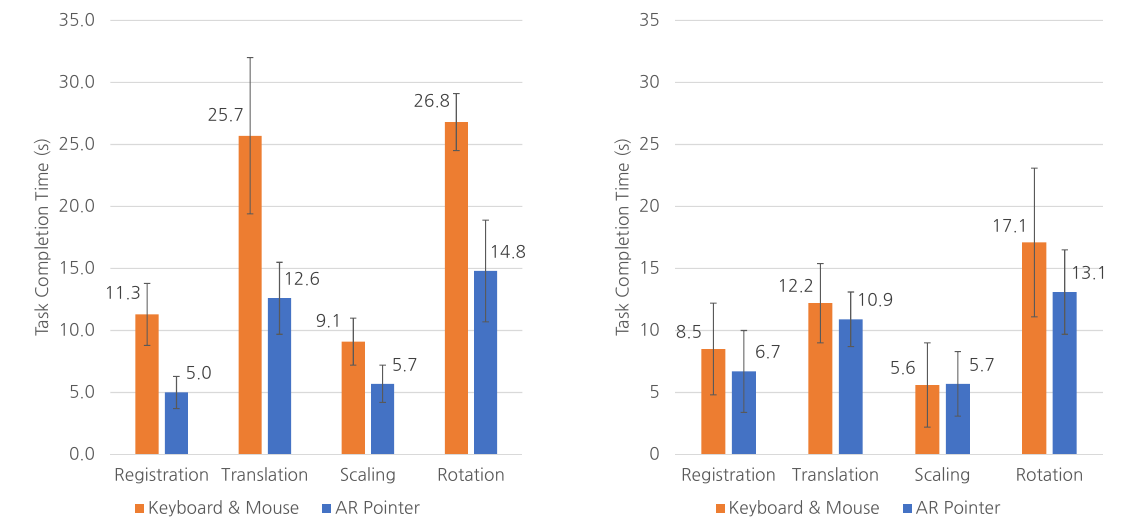
Figure 4. Result of experiment 1 about task completion